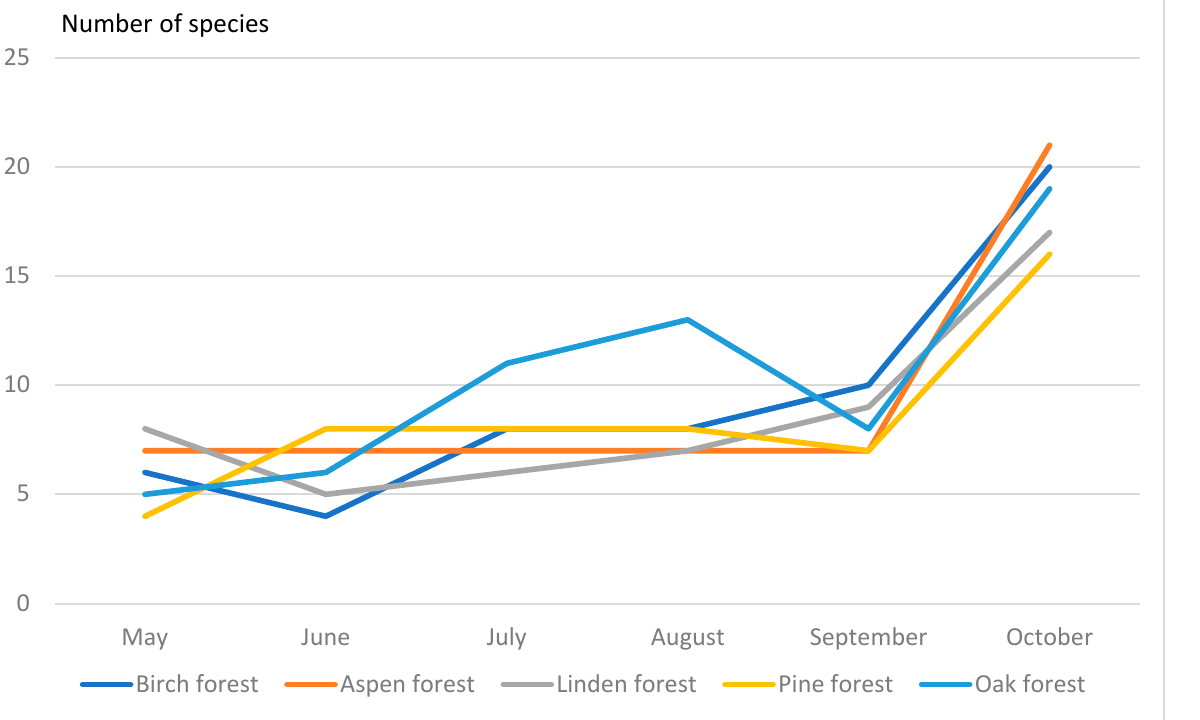
Figure 1. Seasonal changes of species diversity of